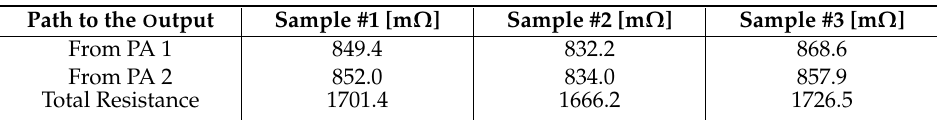
Table 4. Calculated total resistance using the Q factors by inductors from the node for supplying the drain voltage to the output in each module.